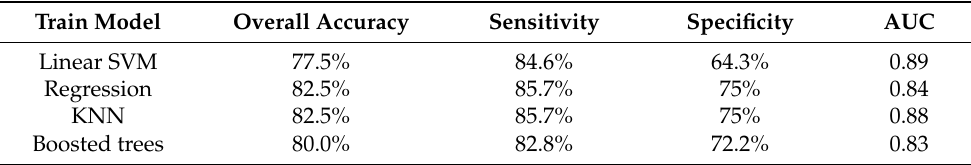
Table 3. The outcome of the MR radiomics prediction model in training group.